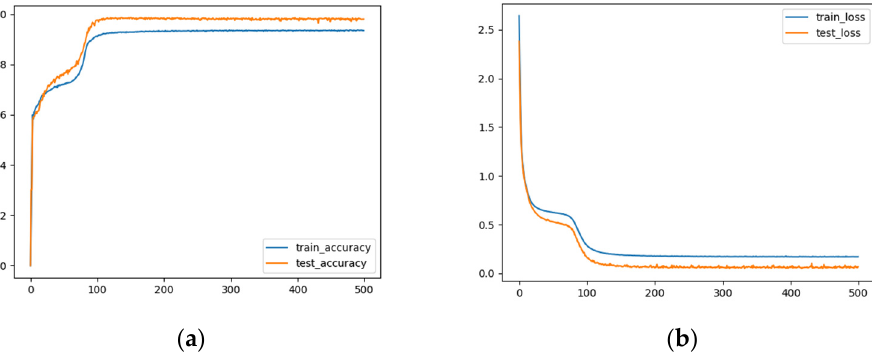
Figure 7. Experimental results of model on the train dataset and validation set. ( a ) Accuracy. ( b ) Loss.